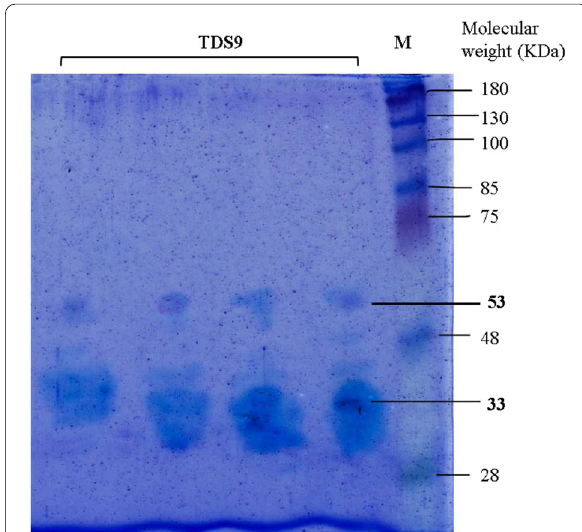
Fig. 5 Photograph of SDS-PAGE gel after staining with Coomasie blue stain. The pre-stained protein marker (ladder) is on the right side of the gel with the bands labeled with their molecular weight in KDa. Protein bands of crude enzyme from TDS9 is marked in bold